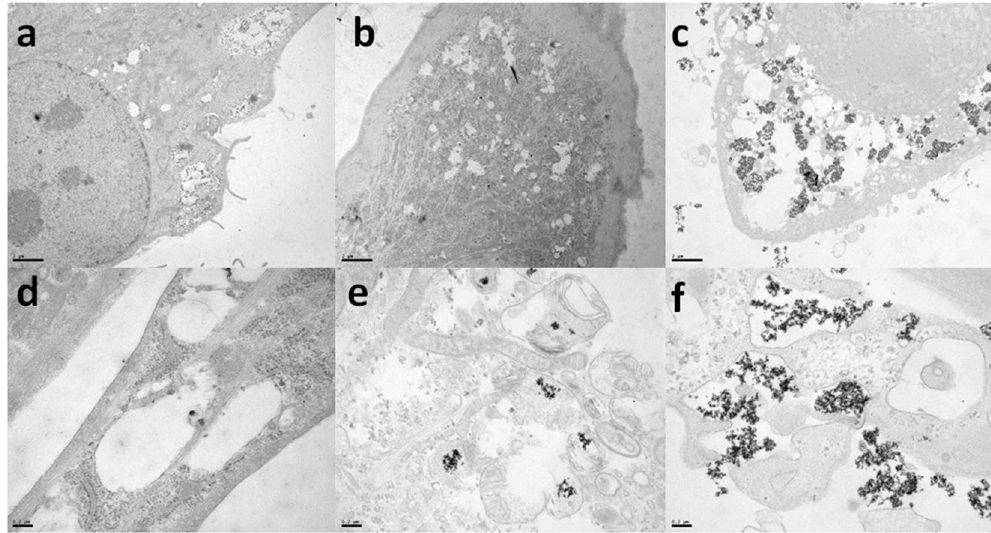
Figure 2. TEM images of hMSCs incubated with IONPs at 50 μ g Fe/ml during 1 h ( a , d ), 4 h ( b , e ) and 24 h ( c , f ). Images a–c obtained with magnification × 8 k and scale bar = 2 μ m and images d–f obtained with magnification × 50 k and scale bar = 0.2 μ